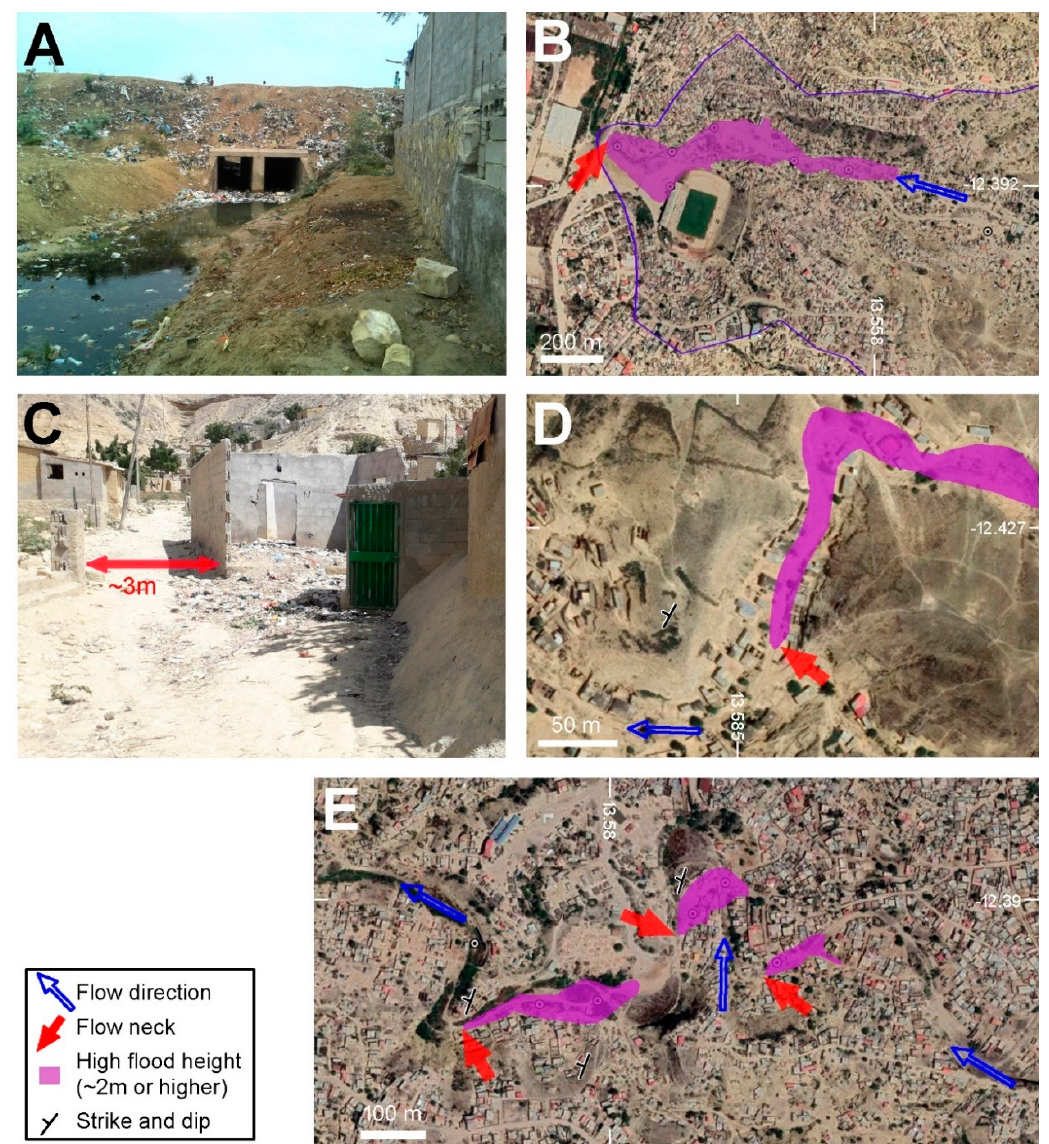
Figure 7. Identification of sites of flow constraint and high flood height. ( A ) The drain connecting the most affected stream catchment during the 2015’s event with the artificial channel for urban drainage with abundant plastic detritus. ( B ) Water levels at the valley bottom for several hundred meters upstream of this point were close to 2 m. ( C ) A narrow street, locally less than 3 m in width, where several human structures collapsed during the 2019 event. ( D ) The site show in ( C ) and the upstream valley stretch with high flood height. ( E ) A recently occupied area where several houses collapsed during the 2015’s event; high-water levels were reached in discrete valley stretches. Satellite images from Google Earth™.